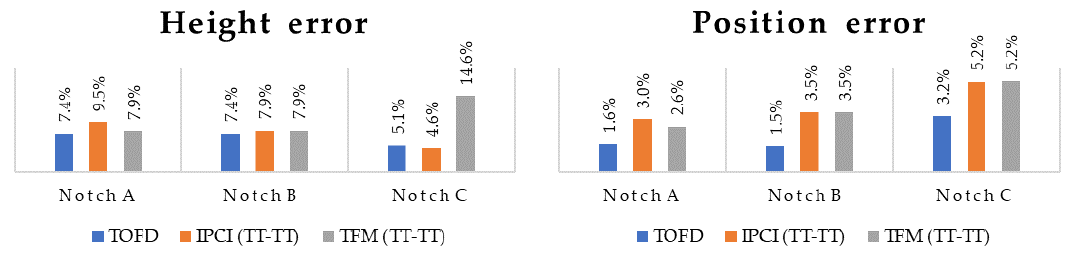
Figure 15. Comparison of height and position error between TOFD, IPCI TT–TT view, and TFM TT–TT view for notches A, B, and C.